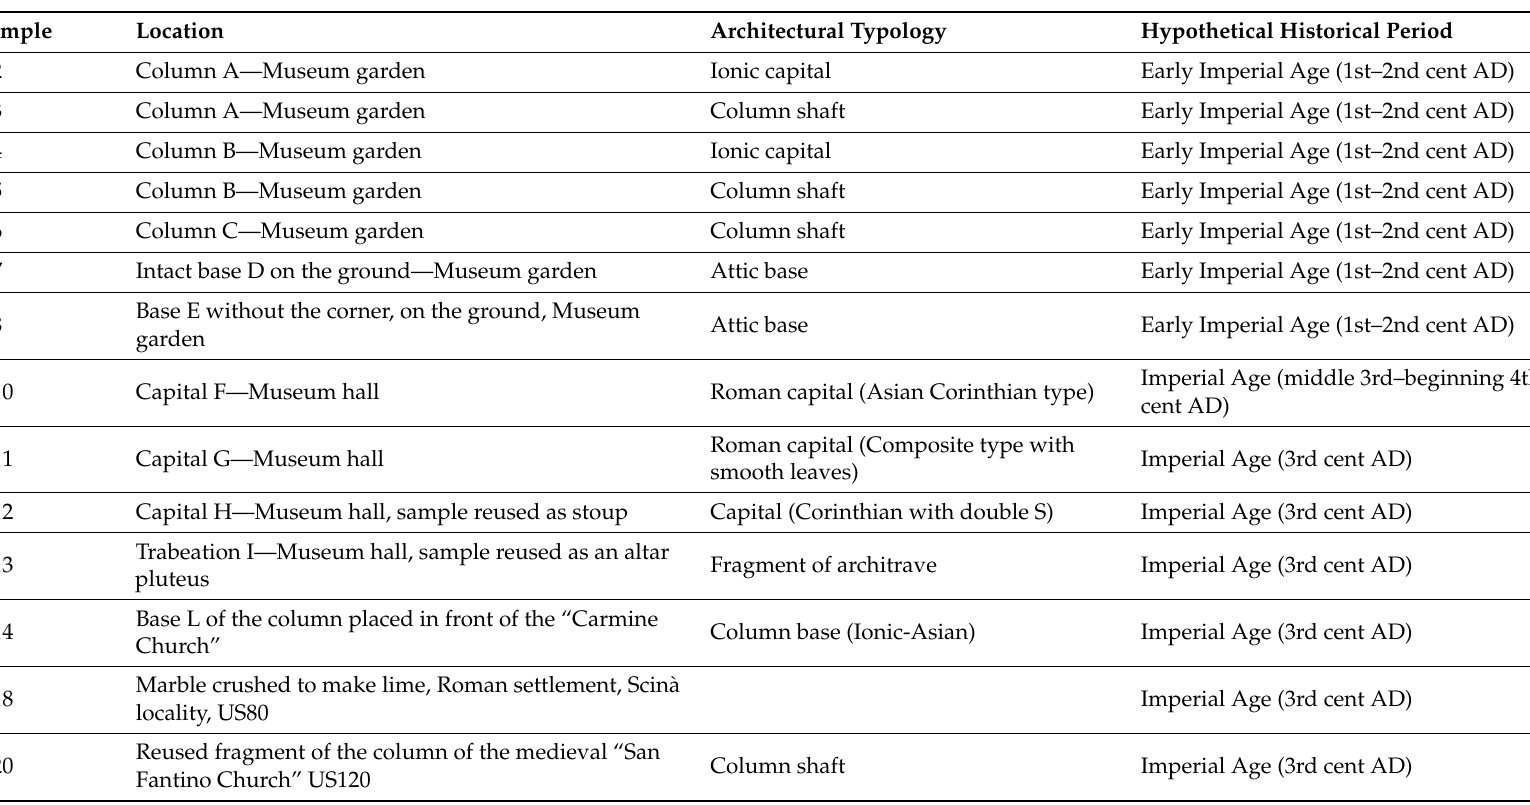
Table 1. Analyzed samples of white marbles from the city of Tauriana with location, architectural typology and hypothetical historical period, based on archaeological data (for columns A, B and C, see Figure